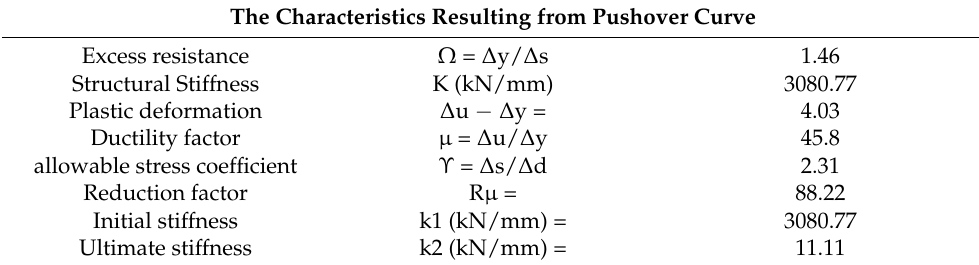
Table 1. The result of model specifications in pushover curve.